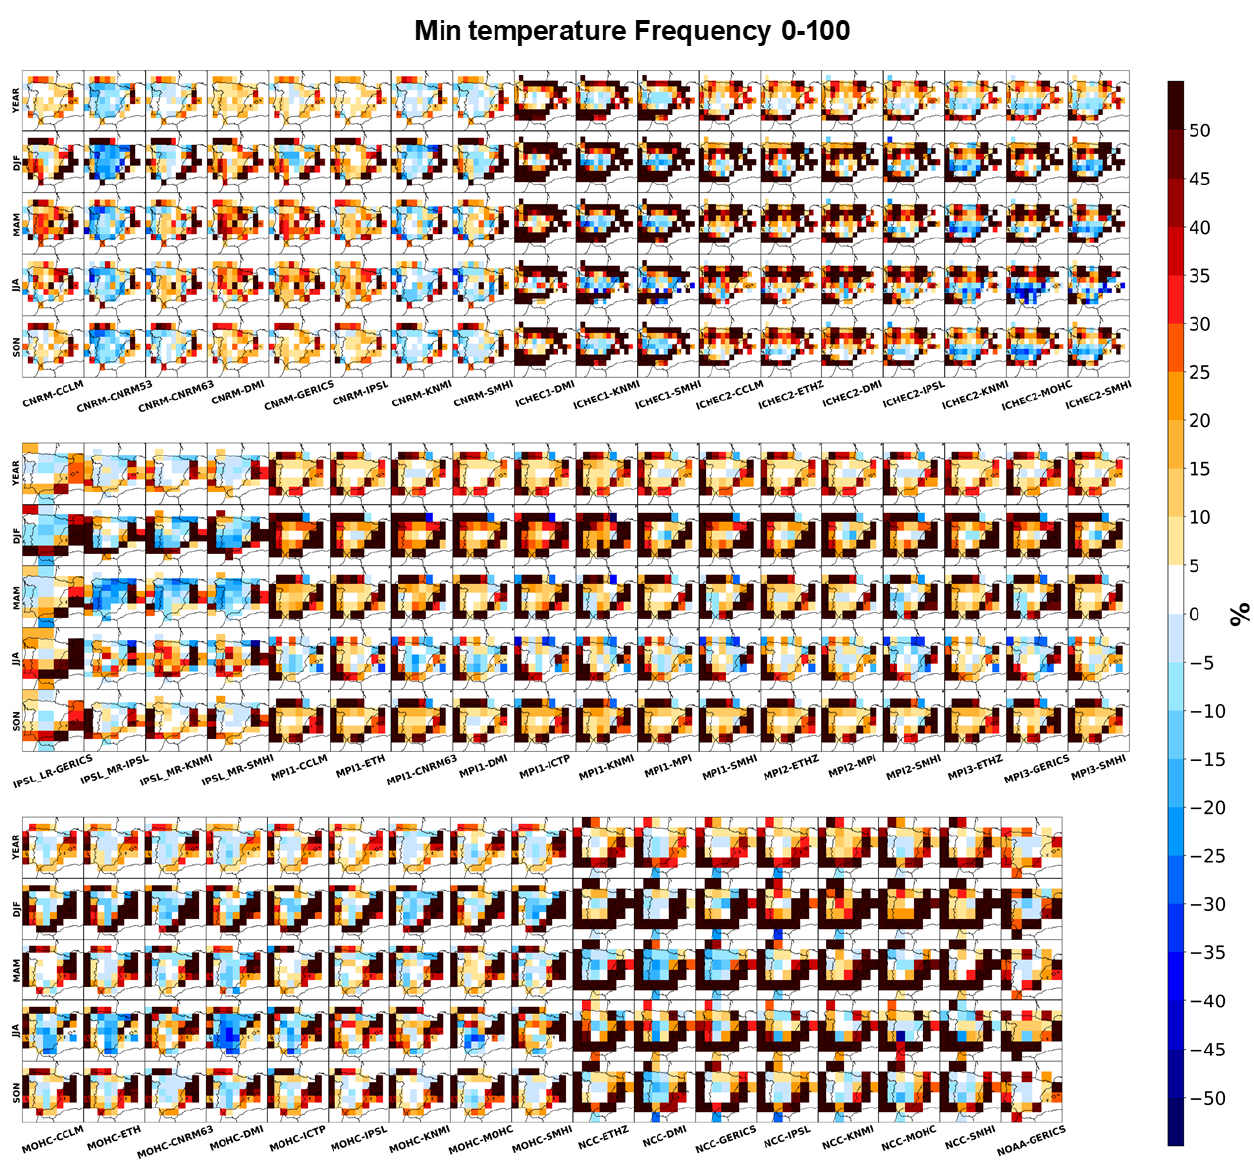
Figure 6. Yearly and seasonal distribution added values (DAVs) of the Iberian Peninsula for the historical (1971–2005) EURO-CORDEX RCMs, with the IGD as a reference for the minimum daily temperature, considering the whole PDF. All RCM data were previously interpo- lated to 0.1 ◦ regular resolution from the observations, while the observations were interpolated into each CMI5 GCM